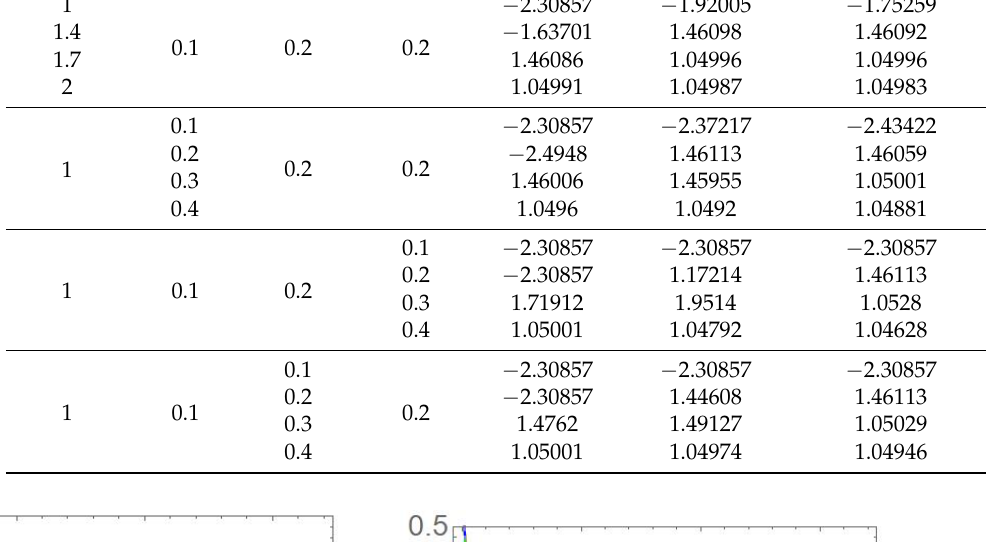
. Figure 4. Impacts of ( a ) Dufour parameter Du on θ ( η ) and ( b ) Radiation parameter Rd on θ ( η ) . 𝜃𝜃 ( 𝜂𝜂 ) 𝜃𝜃 ( 𝜂𝜂 )